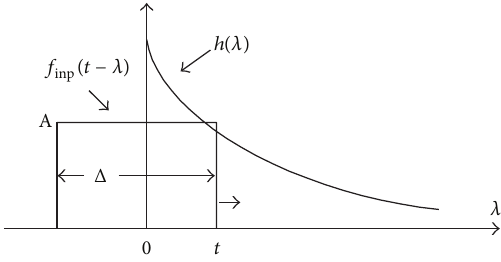
Figure 9: The functions appearing in the integrand of the convo- (𝑡 − 𝜆) is riding (being moved) lution integral (10). The “block” 𝑓 inp to the right on the 𝜆 -axes, as time passes. We multiply the present curves in the interval 0 < 𝜆 < 𝑡 and, according to (10), take the area under the result, in this interval. When 𝑡 < Δ , only the interval (0, 𝑡) is relevant to (10). When 𝑡 > Δ , only the interval (𝑡 − Δ,𝑡) is actually (𝑡) becomes relevant, and because of the decay of ℎ(𝑡) , 𝑓 out